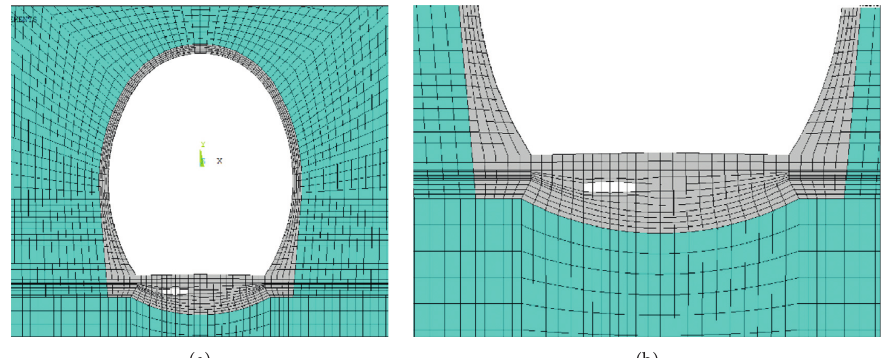
Figure 13: Computational